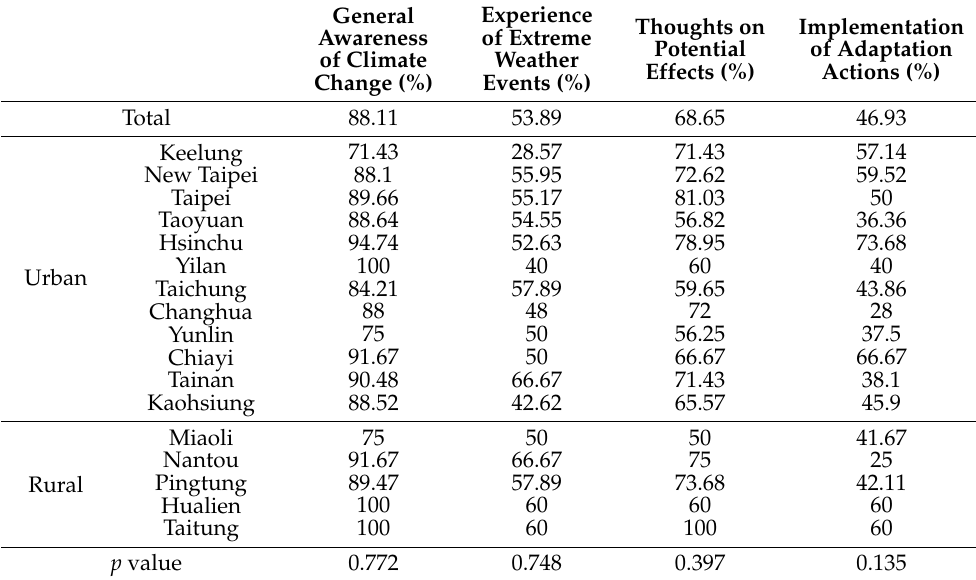
Table 10. Differences in the awareness and experiences of climate change and adaptation actions of respondents from different places of residence. Experience General Thoughts on Implementation of Extreme Awareness Potential of Adaptation Weather of Climate Effects (%) Actions (%) Events (%) Change (%) Total 88.11 53.89